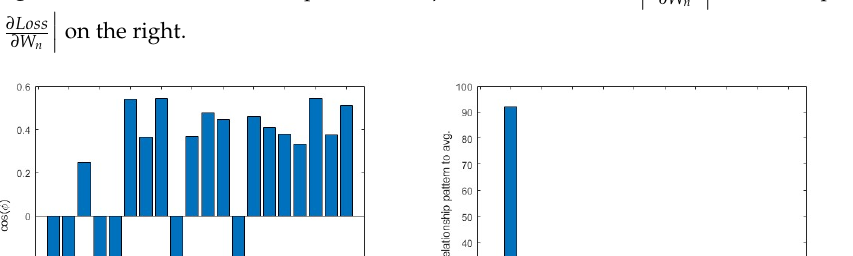
(cid:3339) (cid:4698) relationship to the average (cid:3105)(cid:3024) (cid:3289) (cid:12) (cid:12) ∂ Loss µ (cid:3339) (cid:12) (cid:12) (cid:4698) relationship to the average (cid:12) relationship to the average (cid:12) ∂ W n (cid:3105)(cid:3024) (cid:3289)